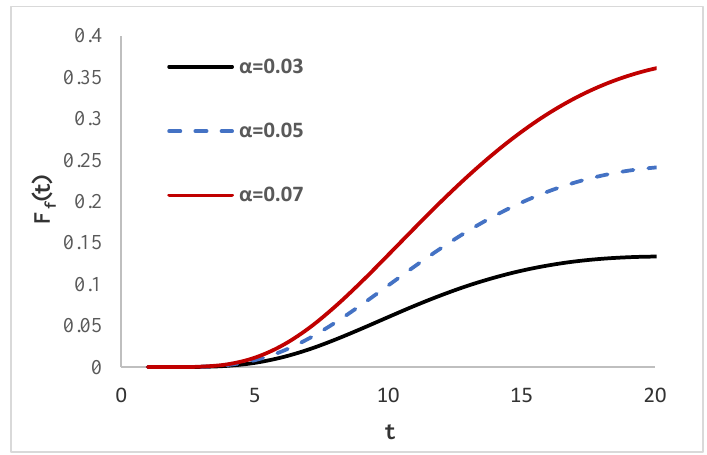
Figure 6. Effect of  on failure frequency